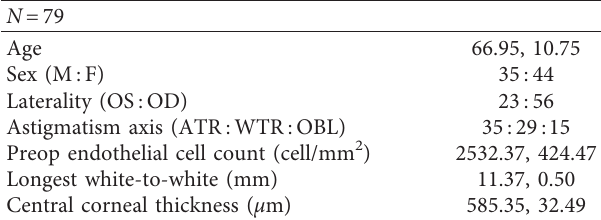
Table 1: Preoperative patient characteristics and ocular biometric